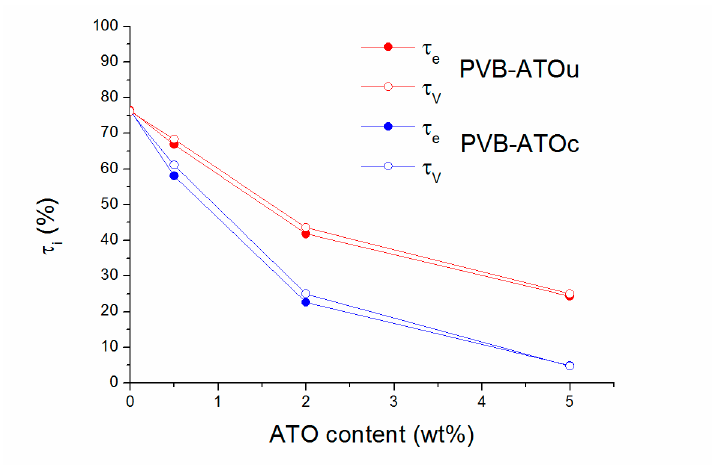
Figure 11. Visible light transmittance, τ v , and solar direct transmittance, τ e , as a function of the ATO content.